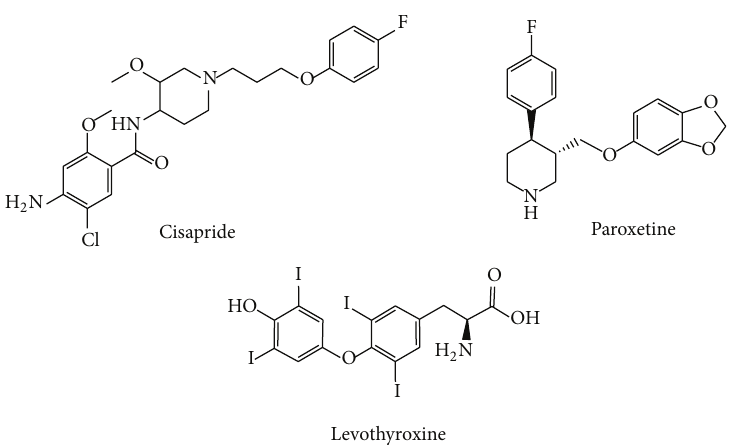
Figure 5: Molecular structures of the three candidates selected for enzymatic